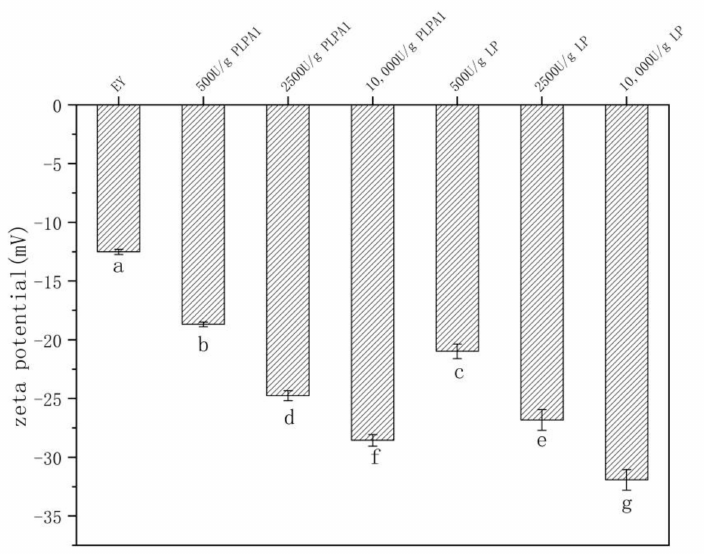
Figure 1. Zeta potential of EY under different concentrations of PLPA1 and LP hydrolysis. (Samples correspond to Table 1). Different letters for the same parameter indicate significant differences ( p < 0.05) between treatments.